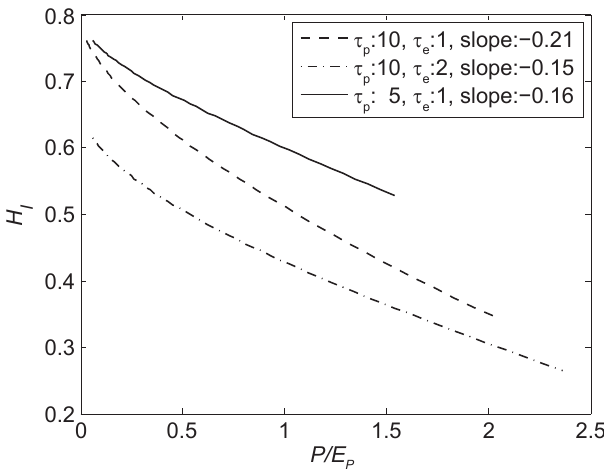
Fig. 7. Horton index H as a function of humidity index P/E P com- puted for W ∈ [ 0 . 2 , 1 ] ; for each parameter set, only part of the hu- midity index domain is covered by the possible model